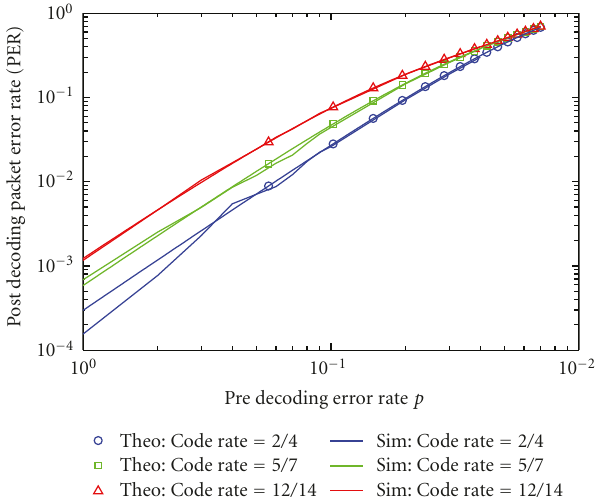
Figure 4: Packet error rate for systematic codes with d min = 3.